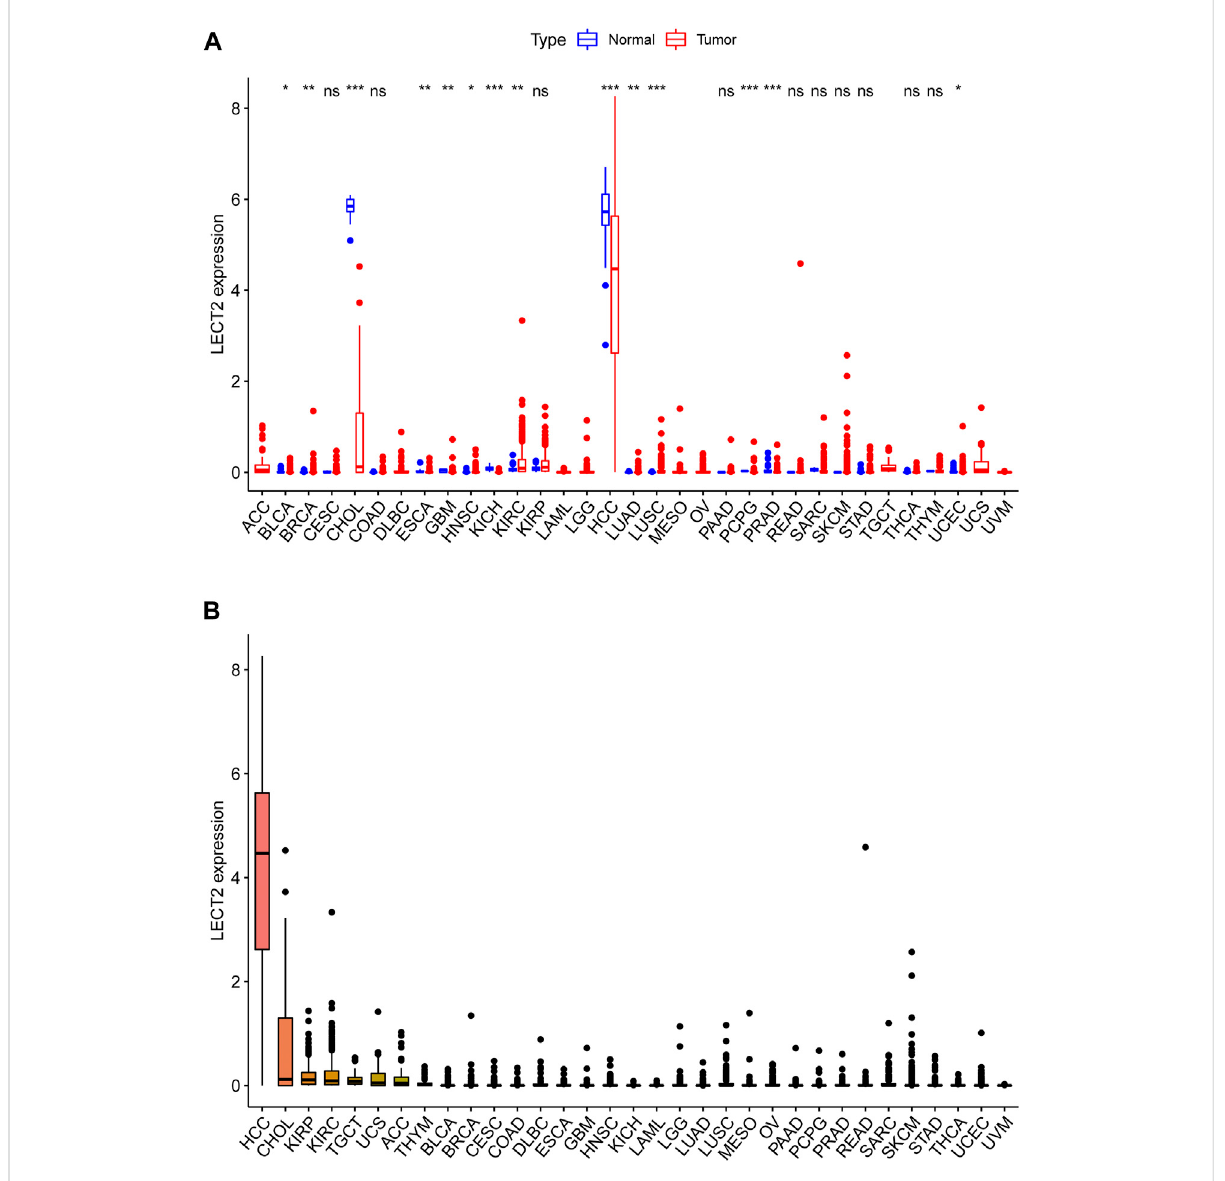
FIGURE 1 LECT2 expression levels comparison. (A) The differential expression analysis between tumor and normal groups of LECT2 in 33 cancers (B) The expression of LECT2 in 33 cancers (from high to low). “ ns ” represents no signi fi cance, "*" represents p < 0.05, "**" represents p < 0.01, and "***" represents p < 0.001